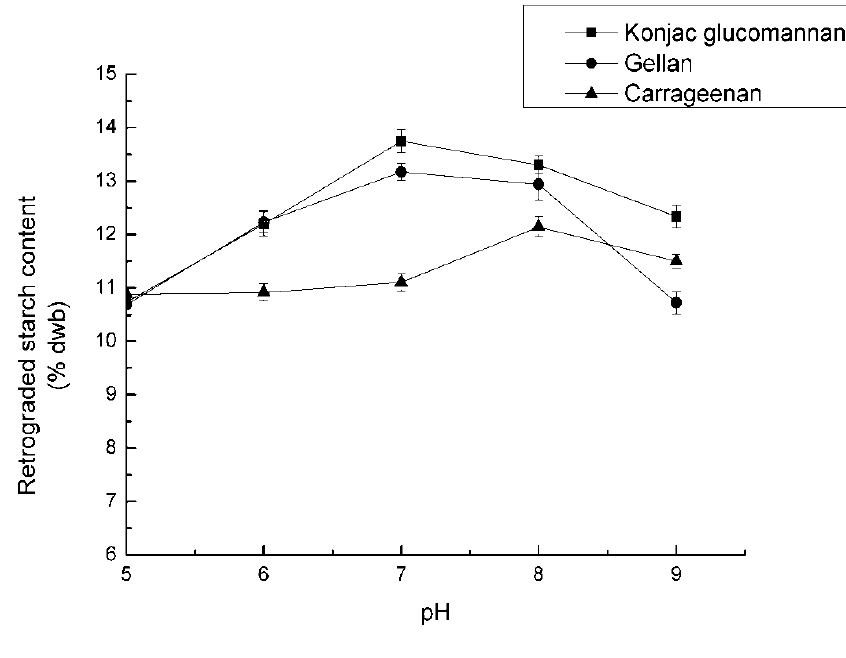
Figure 3. Effect of pH on RS